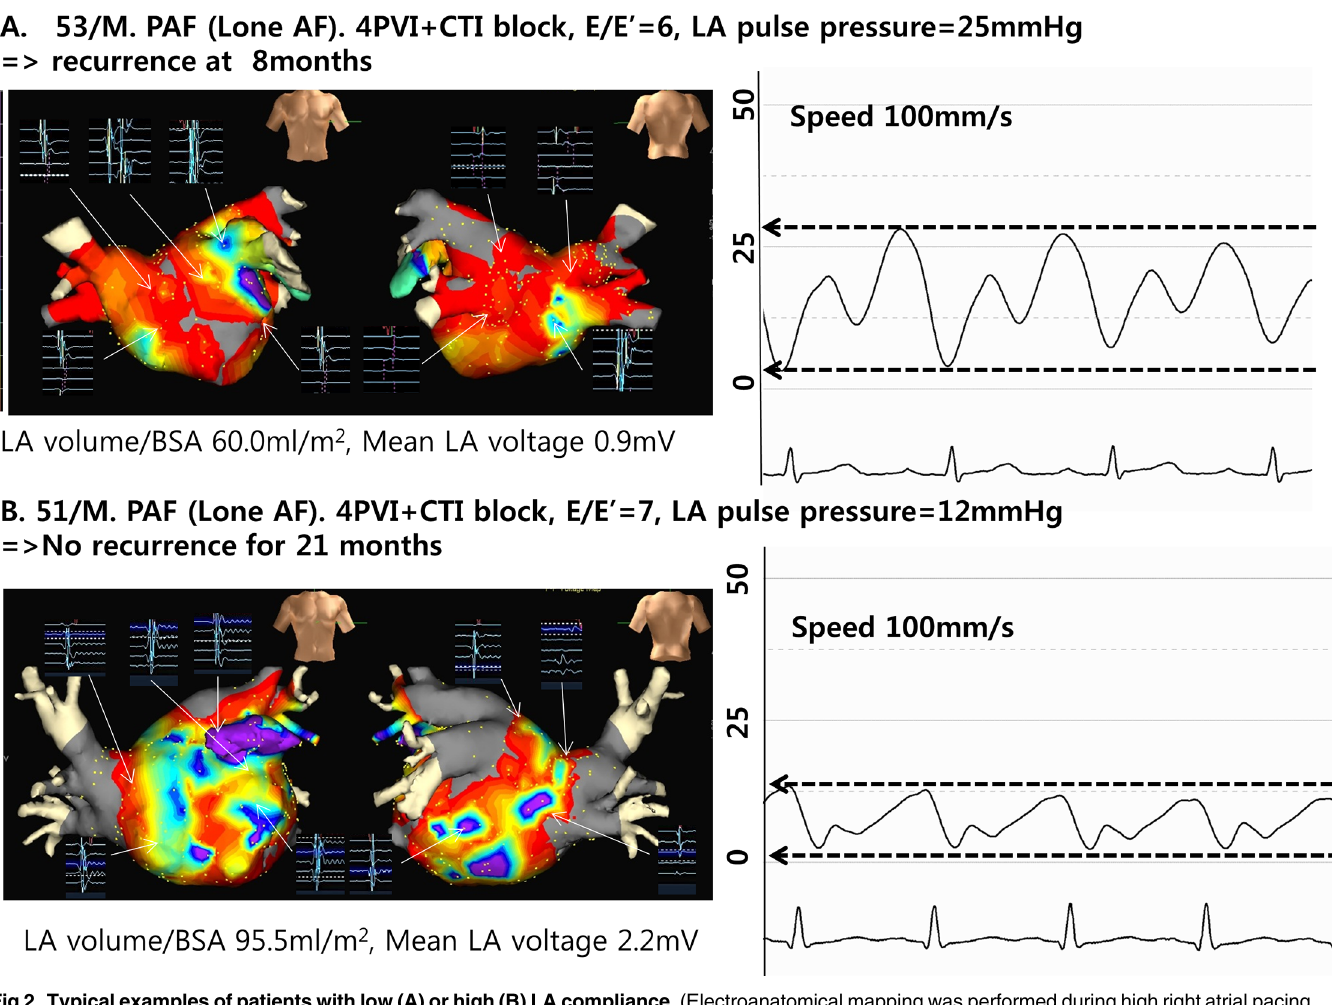
Fig 2. Typical examples of patients with low (A) or high (B) LA compliance. (Electroanatomical mapping was performed during high right atrial pacing 500ms.) Patients with low LA compliance (A) have relatively smaller LA volume and lower endocardial voltage than patients with high LA compliance and show poor clinical outcome of AF after